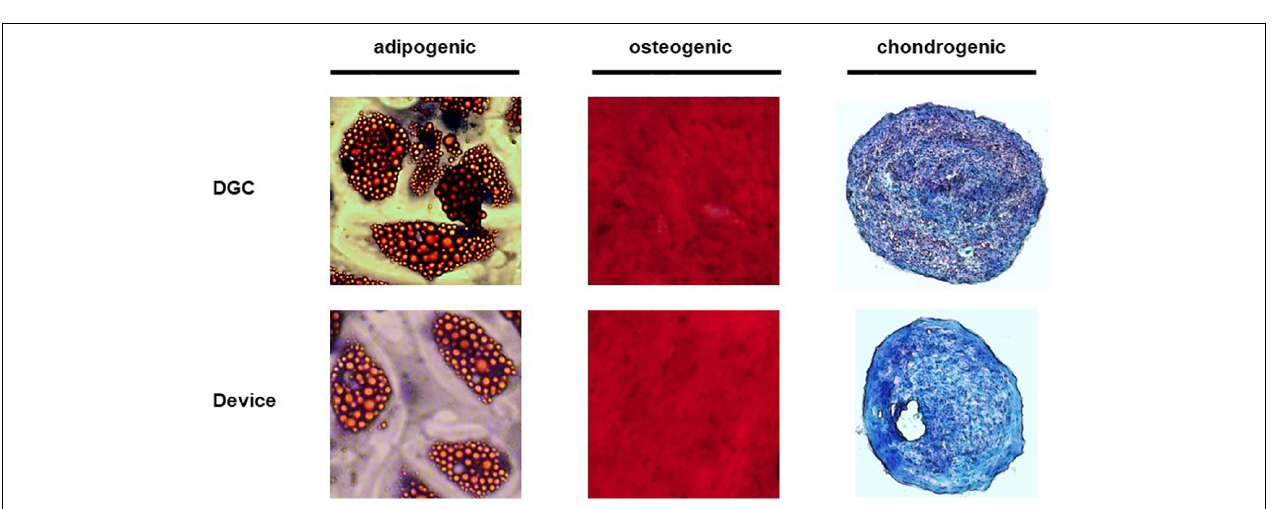
FIGURE 5 | Trophic factors production. Quantification of HGF, EGF, BDNF, angiopoietin-1, and VEGF-A protein in P3 MSC lysates. Protein concentrations are calculated in picograms per million cells. Each data point represents one donor ( n = 4–5 donors) as mean of two technical replicates. Error bars: SEM. Paired t -test.